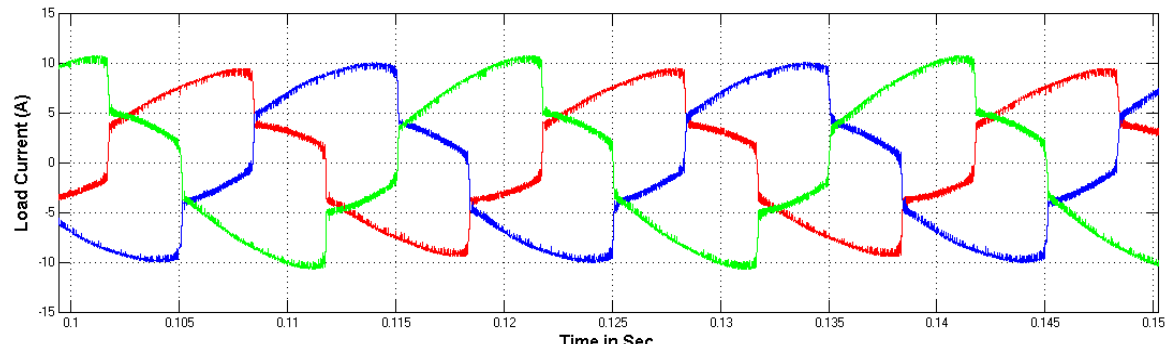
Figure 10. Three-phase load